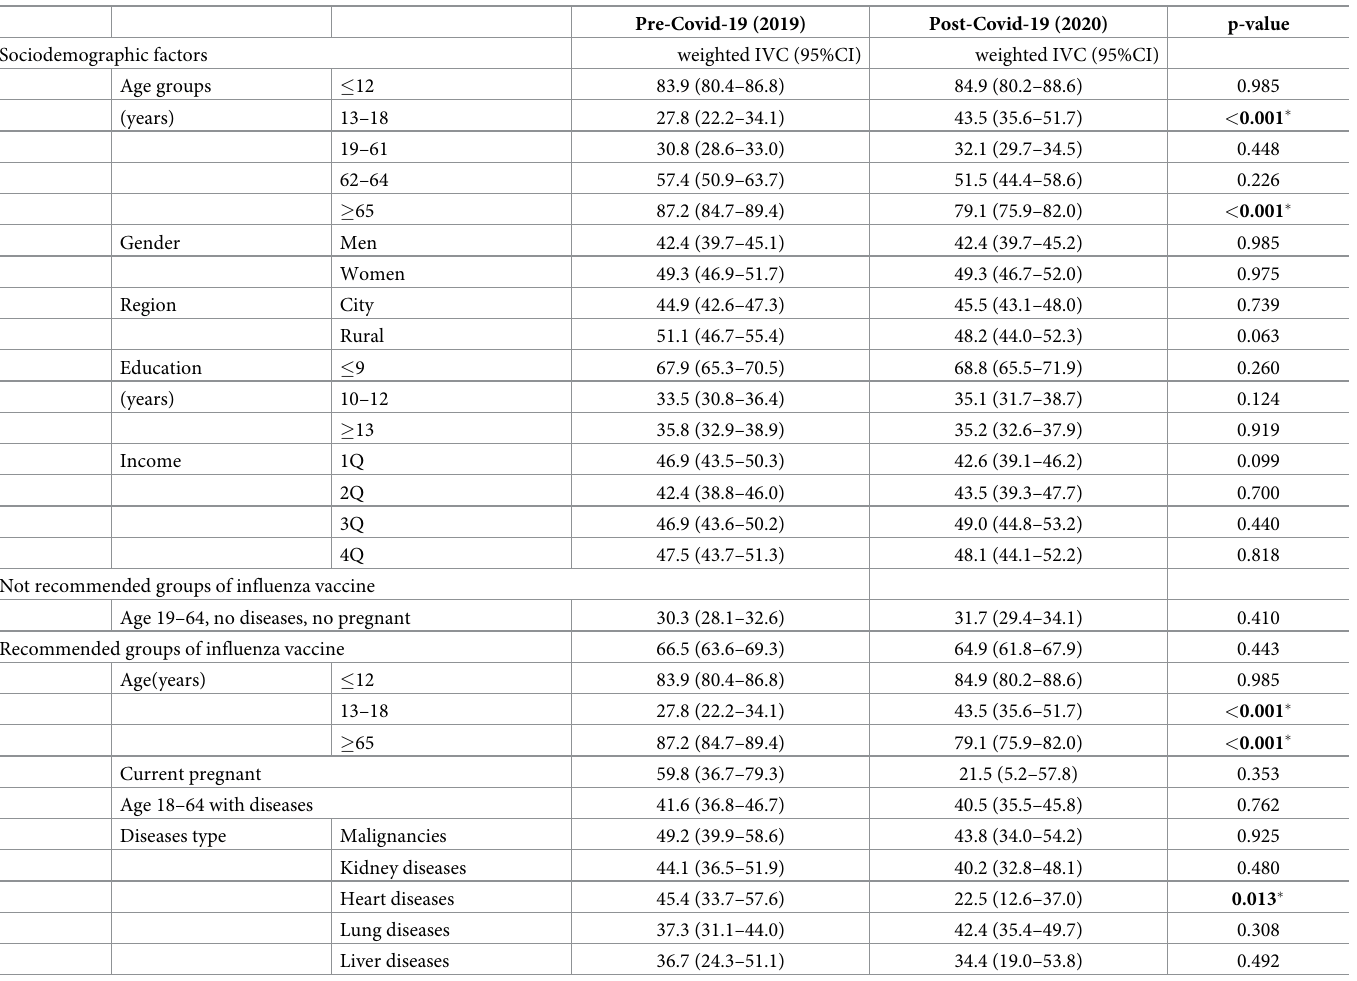
Table 3. Comparison of influenza vaccination coverages between pre- and post-Covid-19